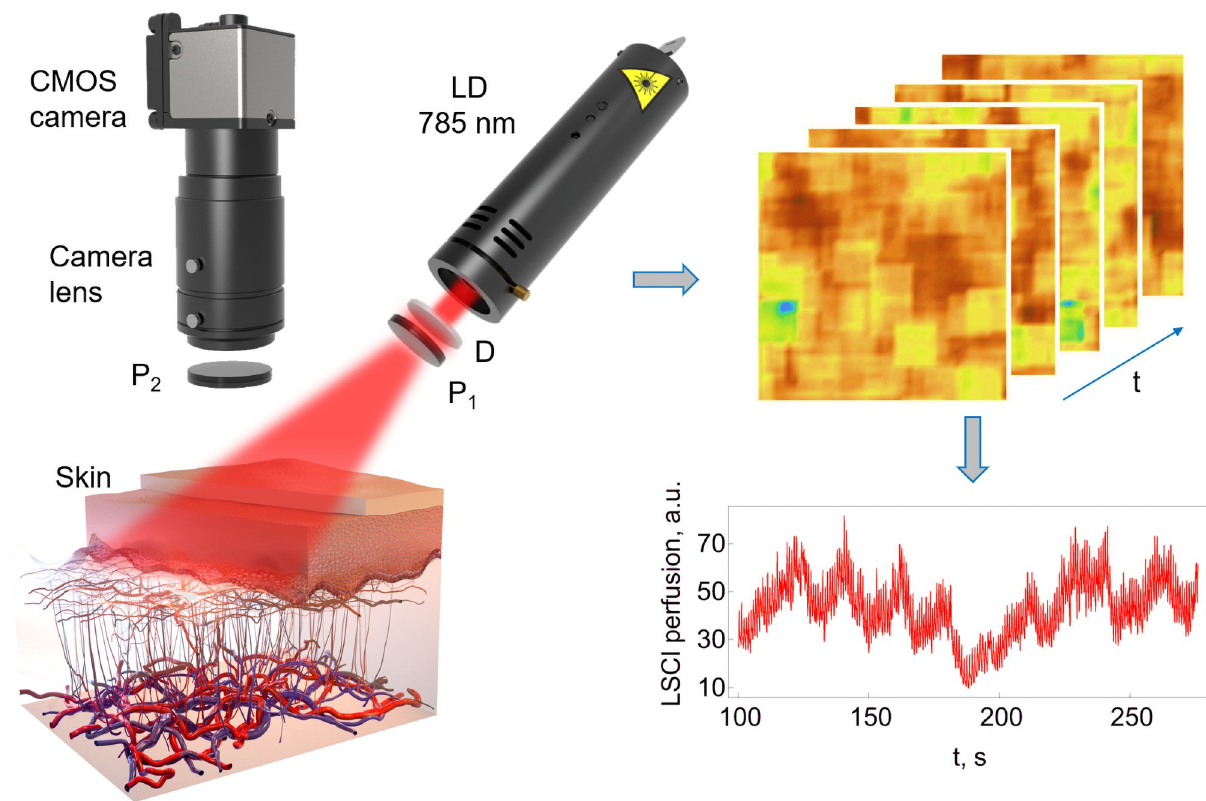
Fig 1. Scheme of the experimental setup and the LSCI pattern plotted using the results averaged over the whole image. LD—laser diode, P 1 and P 2 —linear polarizers,